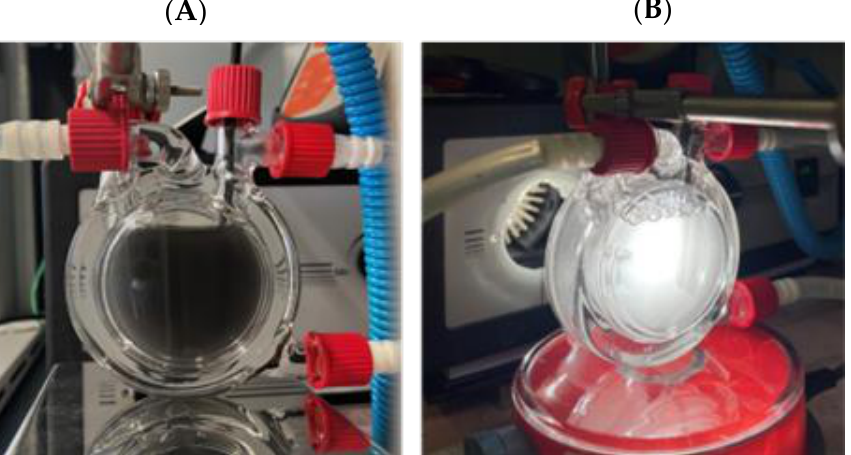
Figure 5. Image of the photocatalytic cell before ( A ) and during ( B ) illumination with xenon lamp.